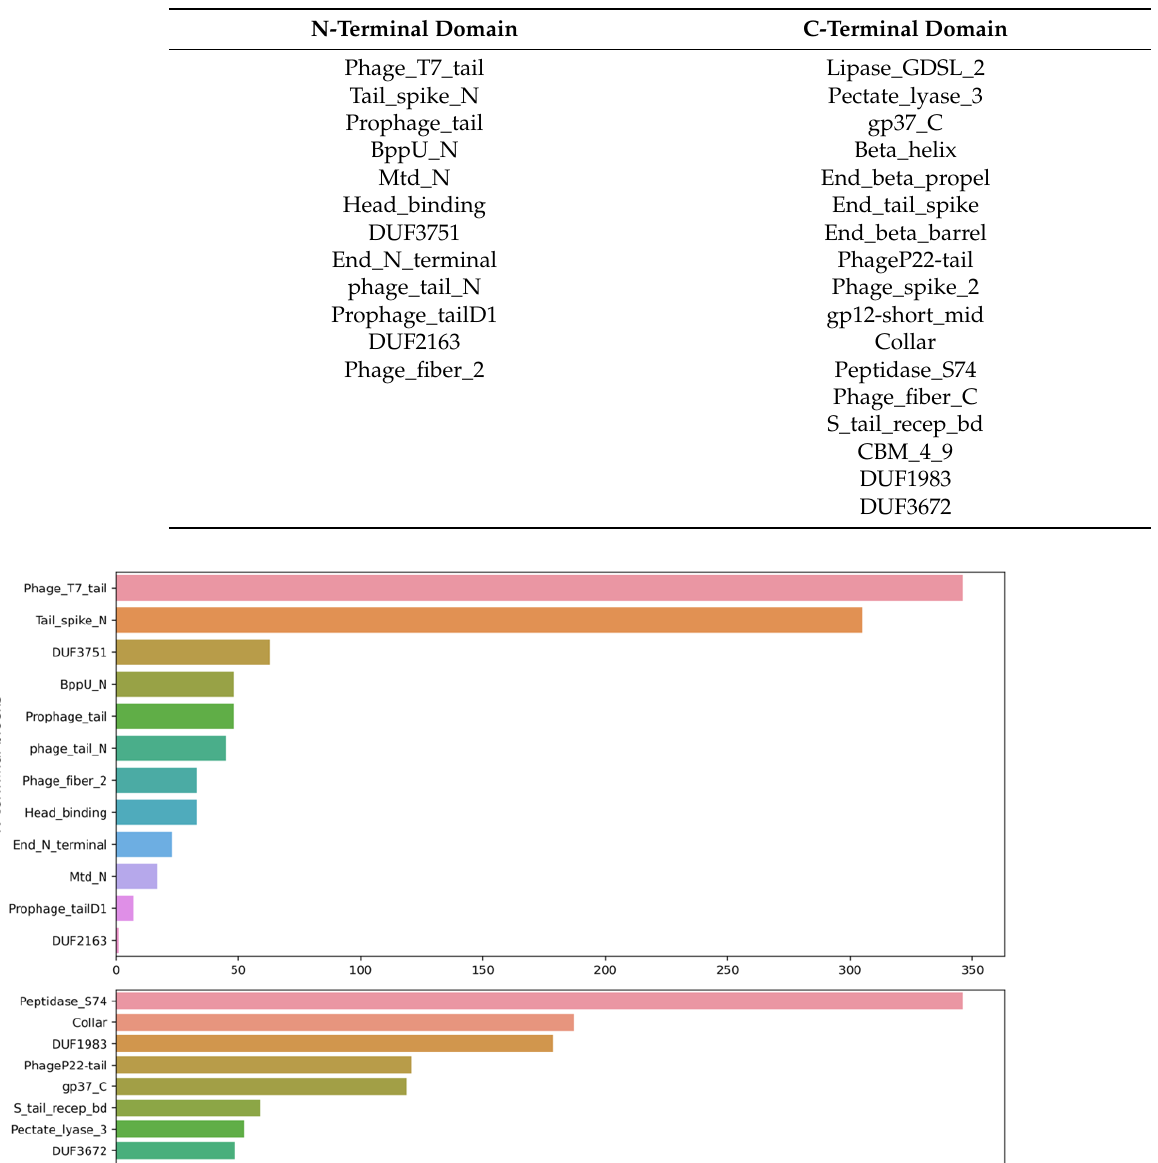
Table 2. RBP-related protein domains collected as HMMs from the Pfam database.